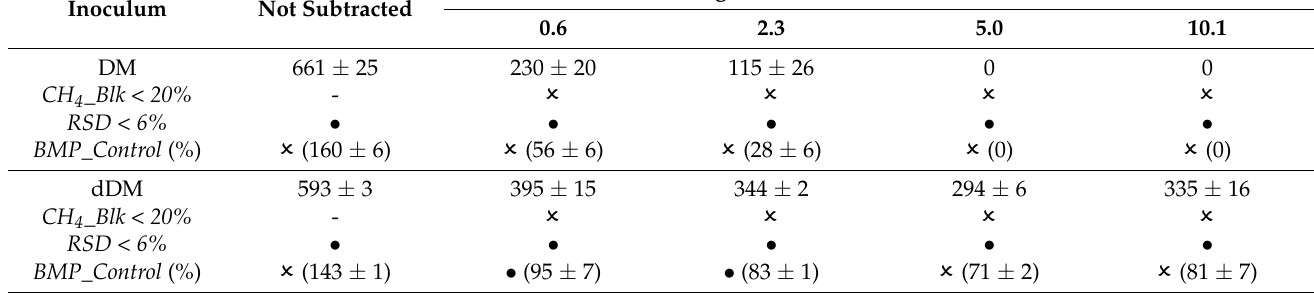
Table 2. BMP values (L ∙ kg − 1 ) of crystalline cellulose using digested sewage sludge (DSS) or degassed DSS (dDSS) as inocula, before and after subtracting the methane produced in the different blanks (Hv ∙ Wv − 1 of 0.6, 2.3, 5.0 and 10.1). The corresponding % of the theoretical BMP max is shown between brackets in BMP_Control (%). The ful fi llment ( ● ) or not (  ) of the proposed validation